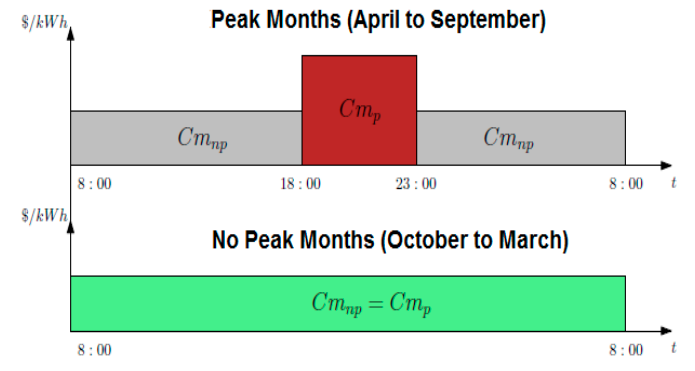
Figure 4. Internal tariff for Sustainable Block™ customers.